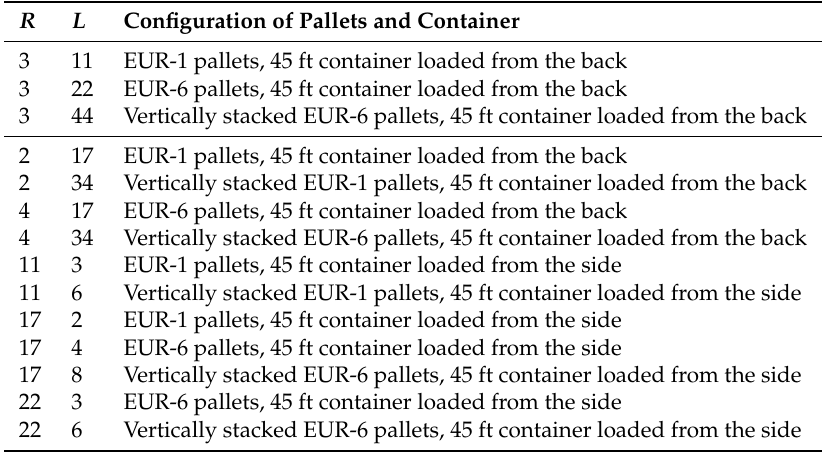
Table 1. Selected values for the number of stacks R and their capacity L based on different pallets and container technologies. The first three rows correspond to values that are covered by existing